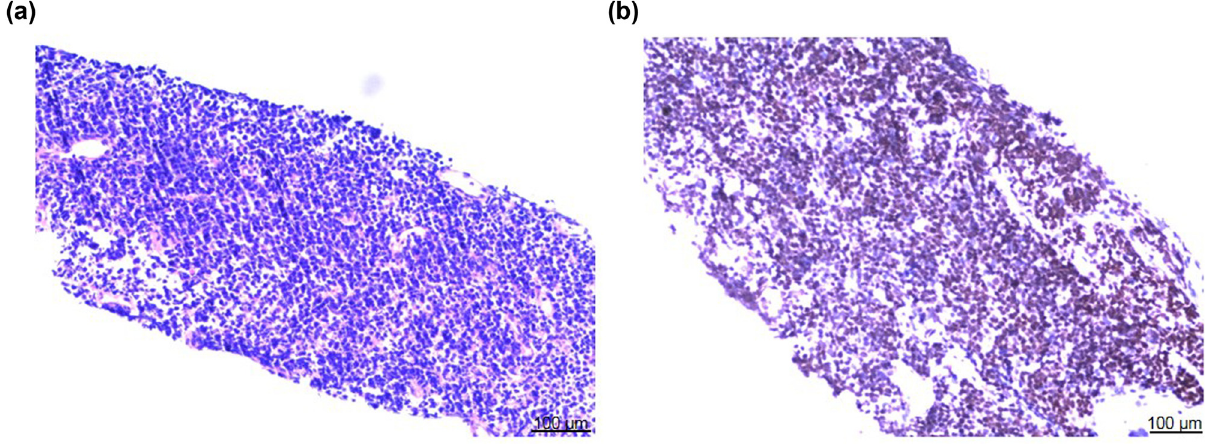
Figure 4: ( a ) HE staining of fi ne needle aspiration sample of thyroid (× 100 ) . ( b ) Positive with PAX - 5 (× 100 )